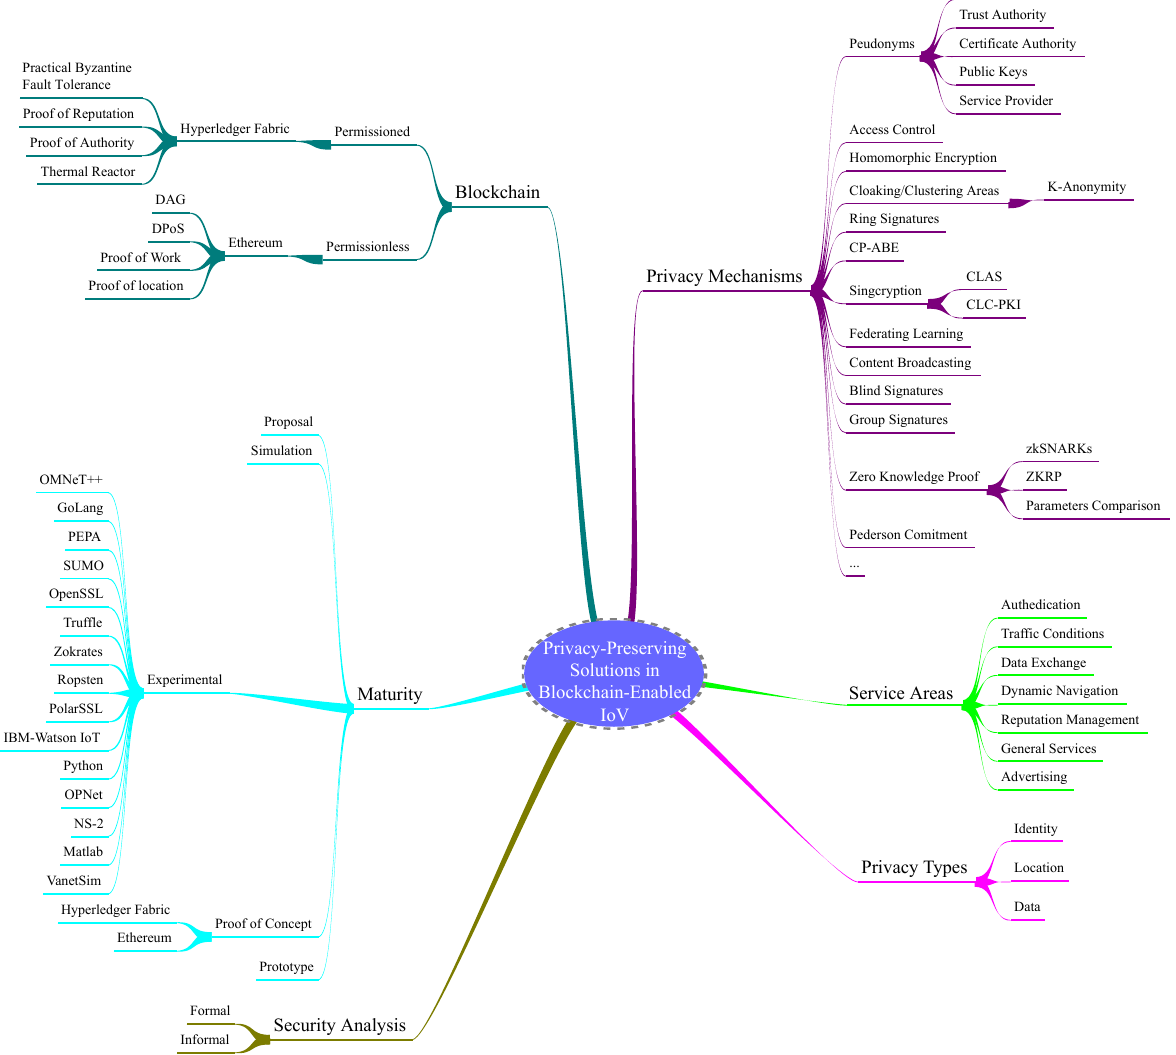
Figure 3. The classification scheme that emerged from the analysis of papers included in this review presented as a mind